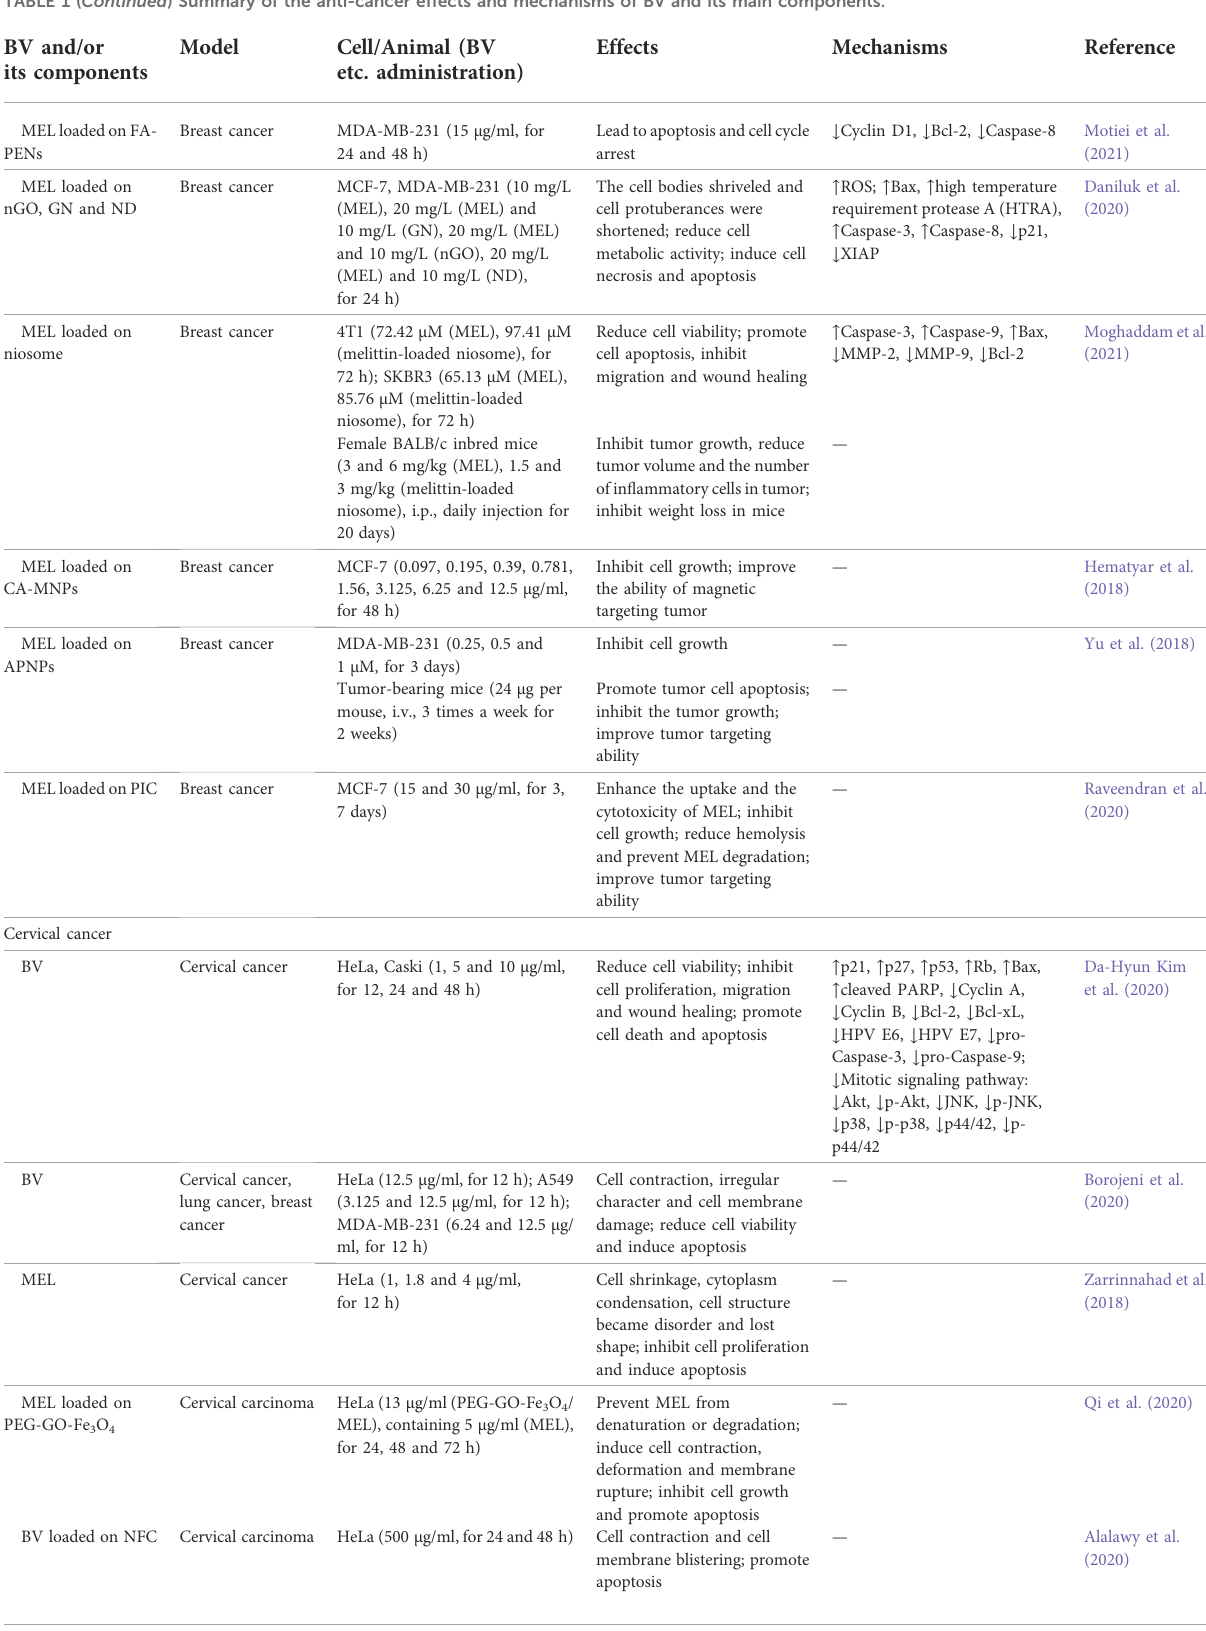
TABLE 1 ( Continued ) Summary of the anti-cancer effects and mechanisms of BV and its main